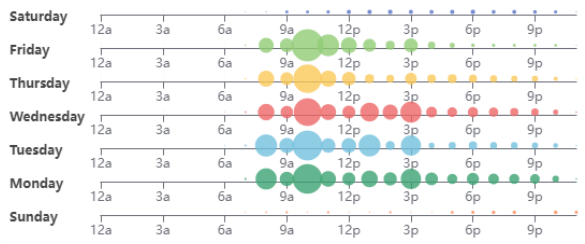
Figure 7 . Timing Characteristics(hour).